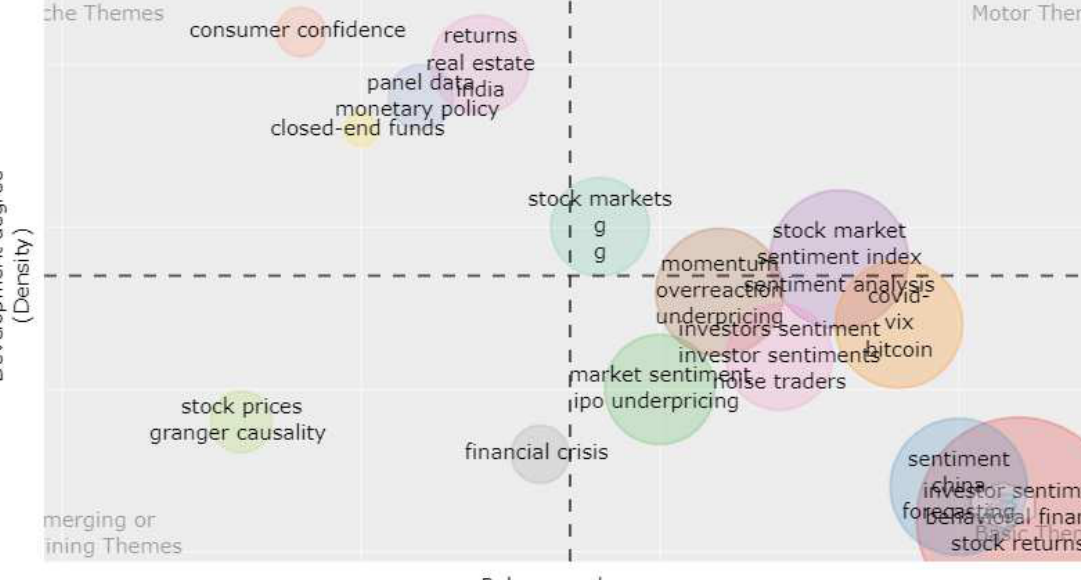
Figure 7. Thematic